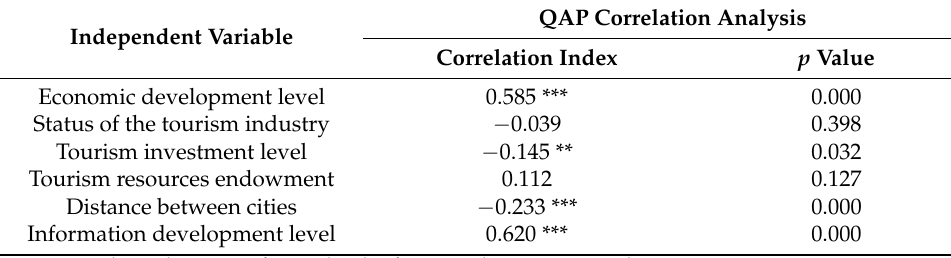
Table 7. Results of QAP correlation